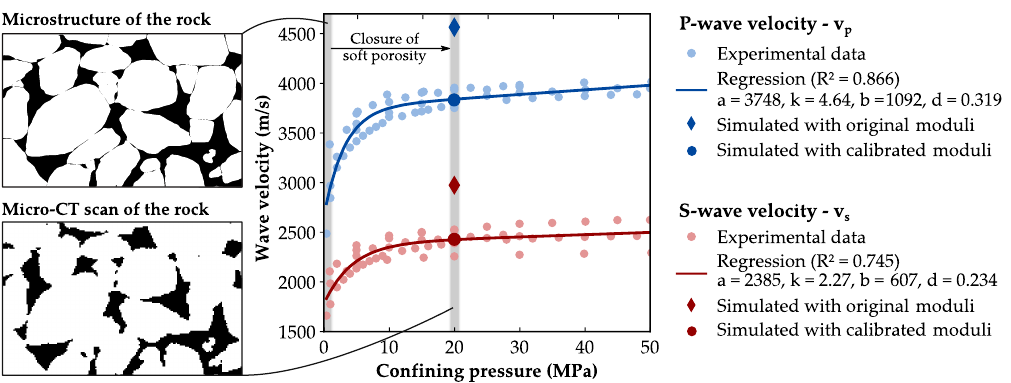
Figure 4. Pressure-dependent laboratory measurements [68–72] of dynamic elastic properties (dots) and the non-linear regression using the empirical relation of Eberhart-Phillips et al. [73] (lines) indicate an exponential increase with rising confining pressures for the Bentheim sandstone until the soft porosity features are closed. The initial mineral moduli of the grain phase are calibrated according to the workflow of Saenger et al. [71], assuming that the effect of the soft porosity features becomes negligible at 20 MPa.